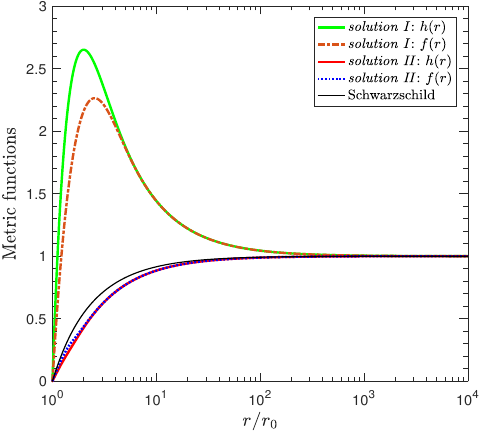
Figure 2 . Functions black hole, h = f = 1